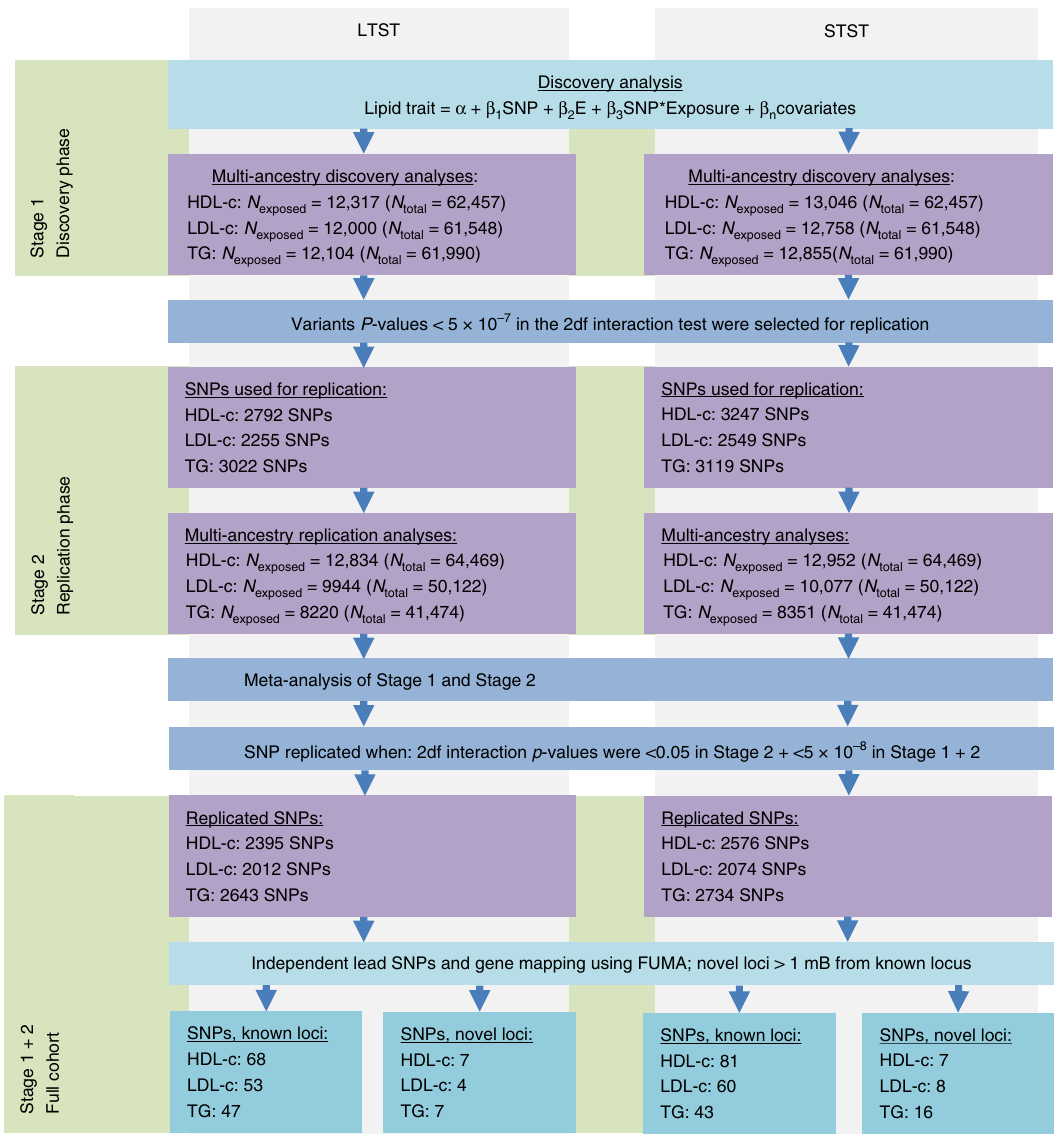
Fig. 1 Project overview and SNP selection in the multi-ancestry analyses. Project overview of the multi-ancestry analyses of how the new lipid loci were identi fi ed in the present project. Replicated variants had to have 2df interaction test P -values of Stage 1 < 5 × 10 − 7 , Stage 2 < 0.05 with a similar direction of effect as in the discovery meta-analysis, and Stage 1 + 2 < 5 × 10 −